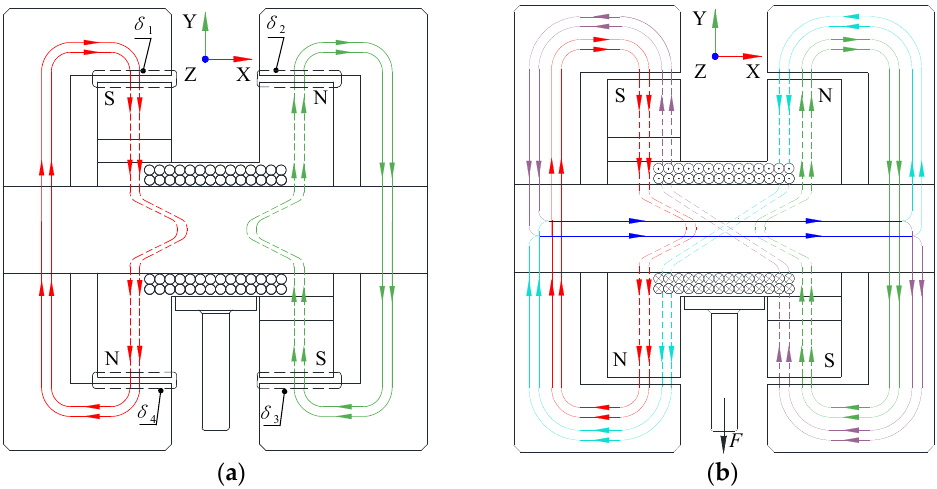
Figure 4. The magnetic circuit topology of the NLFM. ( a ) de-energized; ( b ) energized.